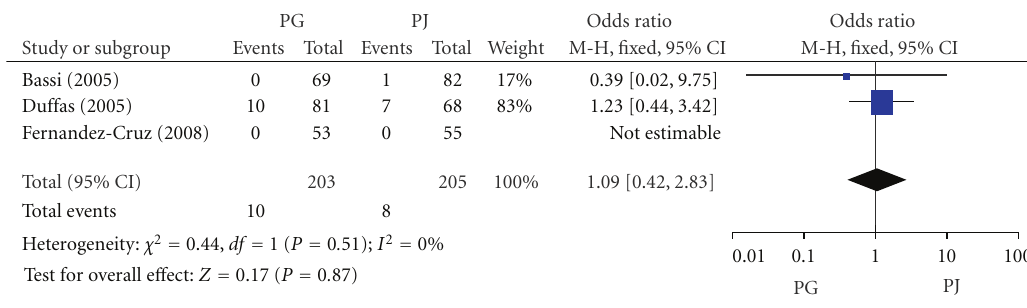
Figure 4: Forest plot of mortality between PG and PJ.